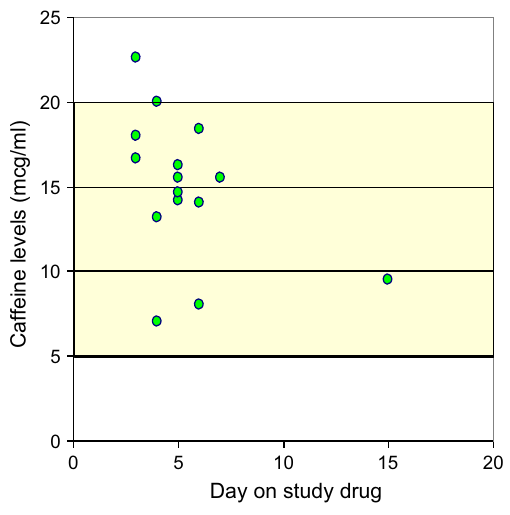
Figure 3: Serum concentrations of caffeine